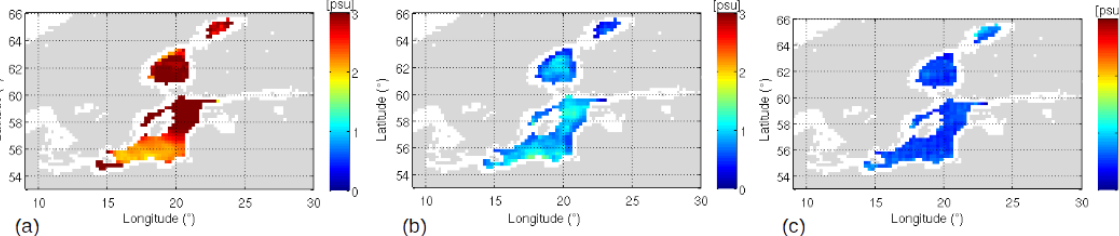
Figure 22. Error standard deviations [psu] for the satellite SSS products computed by CTC for all the collocated maps in 2016: (a) SMAP- JPL (mean error in the basin: 2.81psu), (b) SMAP-REMSS (mean error: 0.83psu), (c) Baltic+ L3 SSS (mean error: 0.56psu).